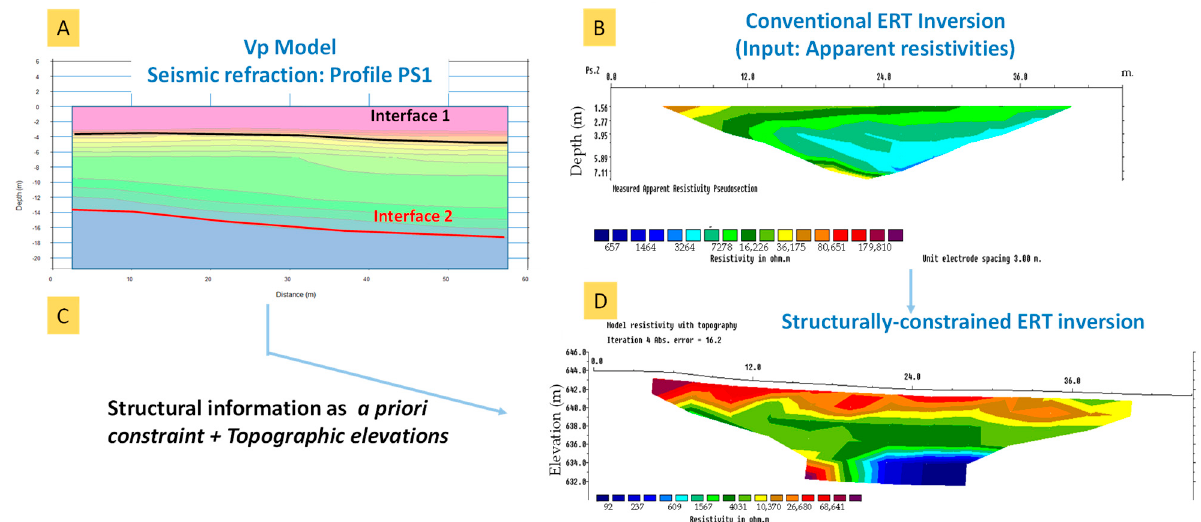
Figure 8. Input data and methodology used to perform an inversion of the structurally − constrained ERT inversion. ( A ) Definition of interfaces 1 and 2 with higher p-wave velocity contrast. ( B ) Input data of apparent resistivity ( C ) Topographic information and ( D ) Result of Profile PS1 using structurally − constrained ERT inversion.